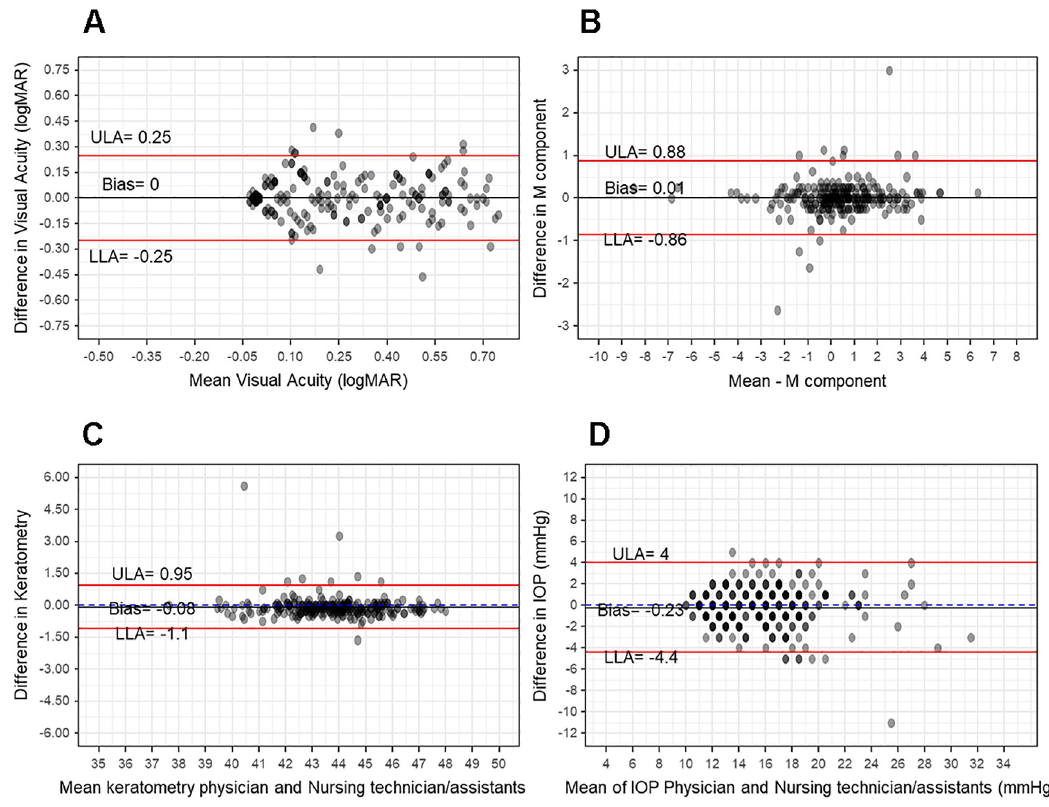
Fig 1. Bland-Altman plots comparing assessments made by doctors and nursing technicians for: A) Visual acuity, in logMAR; B) Autorefraction spherical equivalent (M), in diopters; C) Keratometry, in diopters; and D) Intraocular pressure, in mmHg.